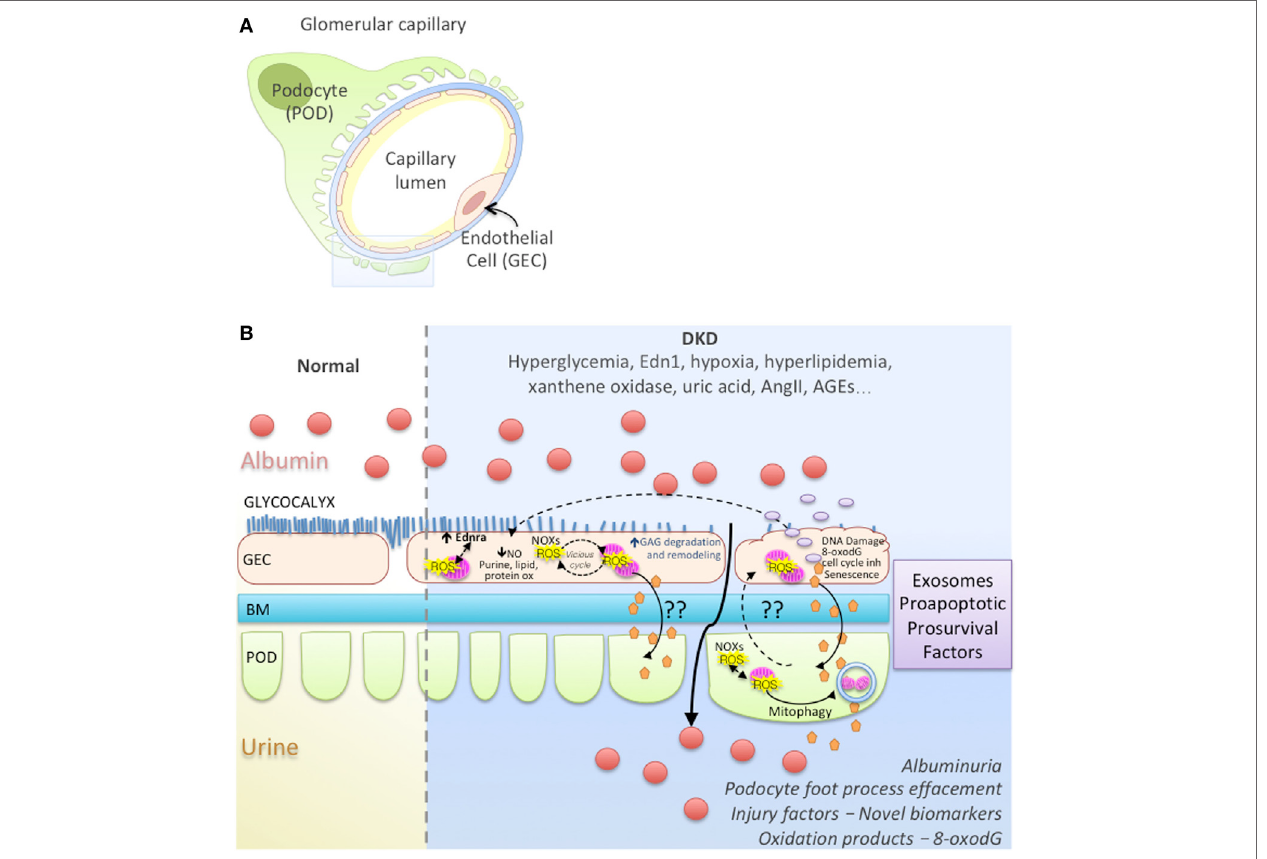
FiGURe 1 | Working model of endothelial cell–podocyte cross-talk in diabetic kidney disease (DKD). (A) Glomerular capillary showing a podocyte (POD; Green), basement membrane (BM; blue), endothelial cell (GEC; pink). (B) Magnified insert from (A) illustrates normal and DKD environment; GEC injury with ROS vicious cycle, mitochondrial dysfunction, glycocalyx loss, endothelial remodeling and cross-talk with podocytes, albuminuria, podocyte foot process effacement in